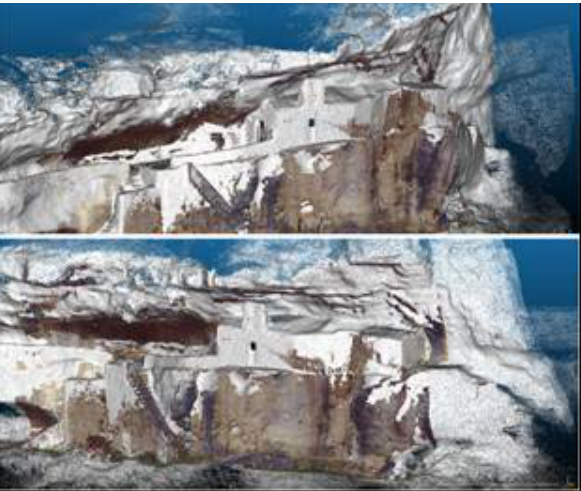
Figure 19. Overlapping point clouds: in white shader, based image